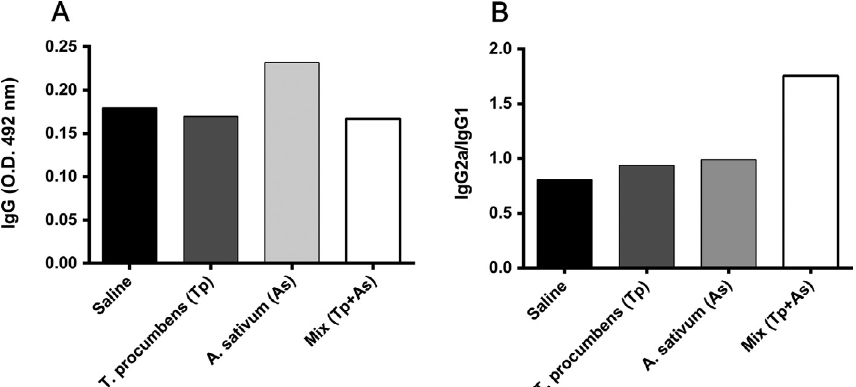
Figure 3. Total levels of IgGs, ratio IgG2a/IgG1 in mice with different treatments compared with PBS-treatment control group. Total IgGs relationship with general humoral immune response and IgG2a/IgG1 related to Th1-type immune response causing protection of cutaneous leishmaniasis. Control group (black bar), T. procumbens group (deep gray bar), A. sativum group (light gray bar) and Mix group (white